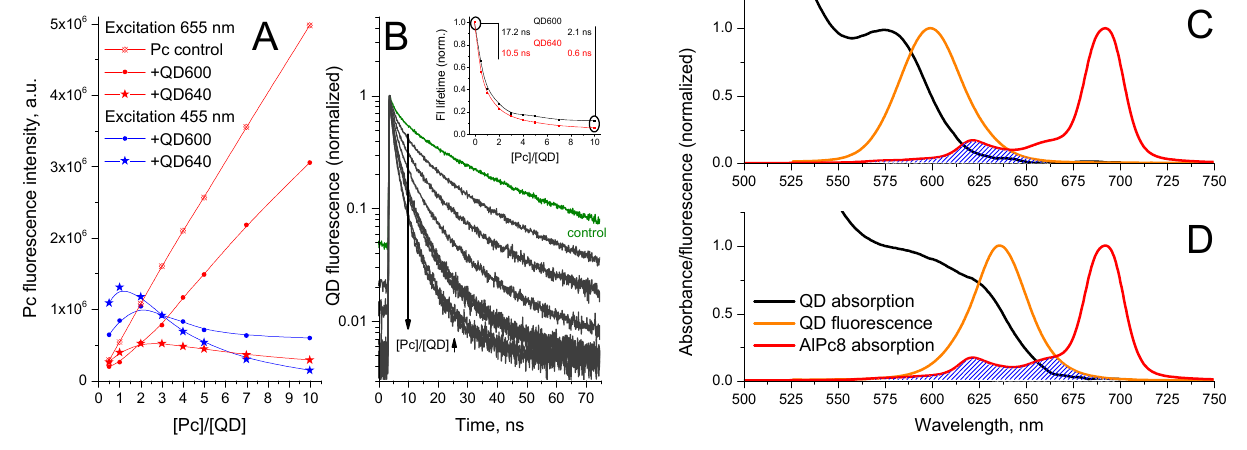
Figure 6. ( A ) Integral fluorescence intensity of AlPc8 in a solution without QDs and in solutions with QD600/QD640 at different excitation wavelengths. ( B ) QD600 fluorescence decay curves in a solution without Pc and in solutions with AlPc8 at various [Pc]:[QD] ratios. The inset shows the average fluorescence lifetimes of QD600 and QD640 in conjugates with AlPc8 as a function of the Pc:QD stoichiometry. Absorption and fluorescence spectra of QD600 ( C ) and QD640 ( D ) in comparison with Pc absorption. The overlap of QD fluorescence and Pc absorption spectra (AlPc8 as example) is indicated. QD fluorescence excitation wavelength is 455 nm.